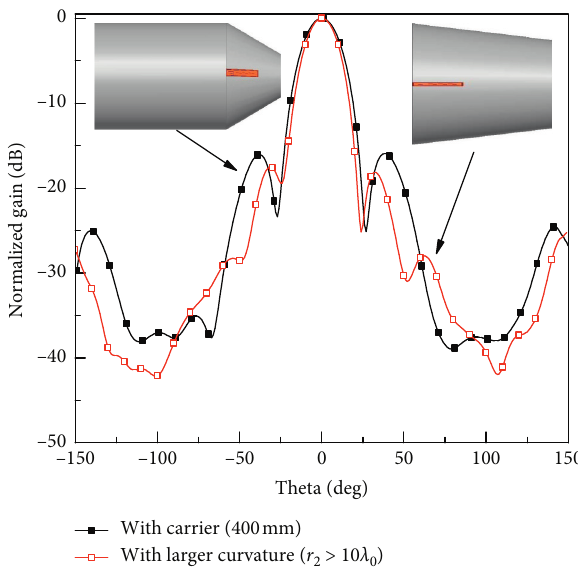
Figure 9: Effect of large curvature and carrier surface on antenna’s radiation characteristics.